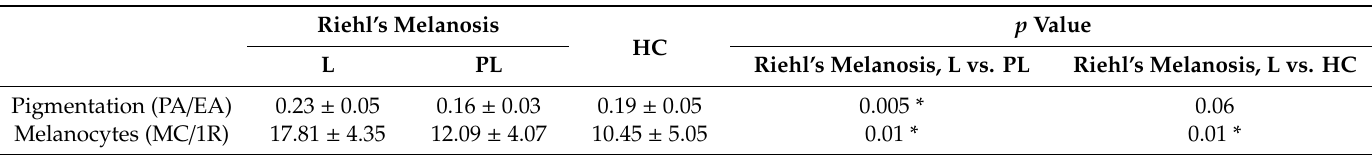
Table 2. Quantitative analysis of epidermal pigmentation and the number of melanocytes in Riehl’s melanosis and healthy controls. p Value Riehl’s Melanosis HC L PL Riehl’s Melanosis, L vs. PL Riehl’s Melanosis, L vs.